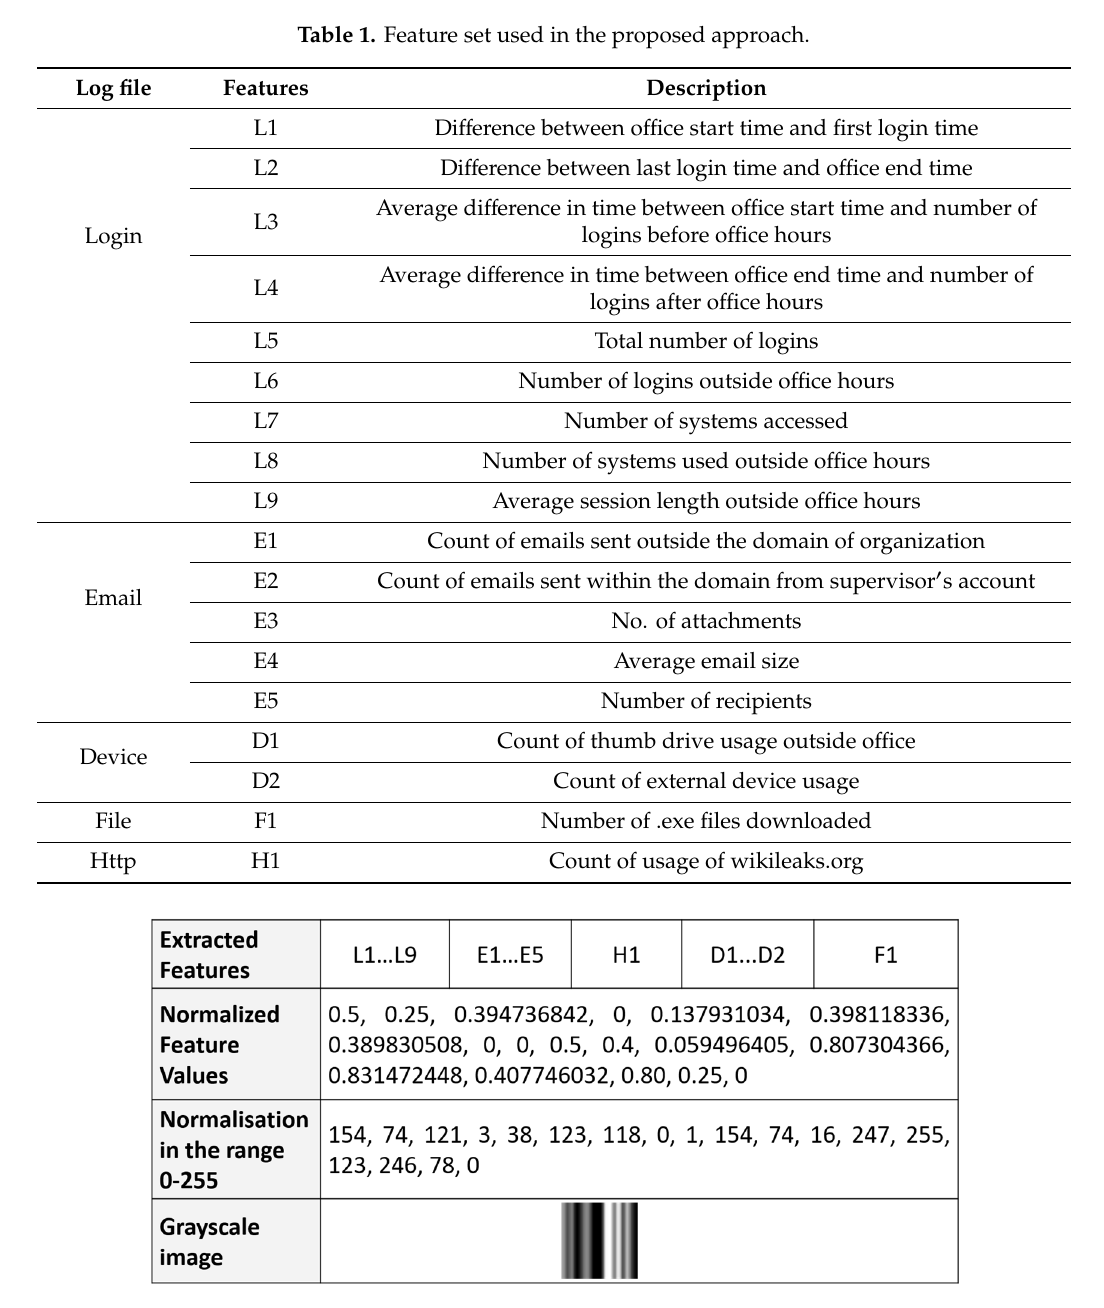
Figure 3. Image representation of the numerical features extracted from log files.